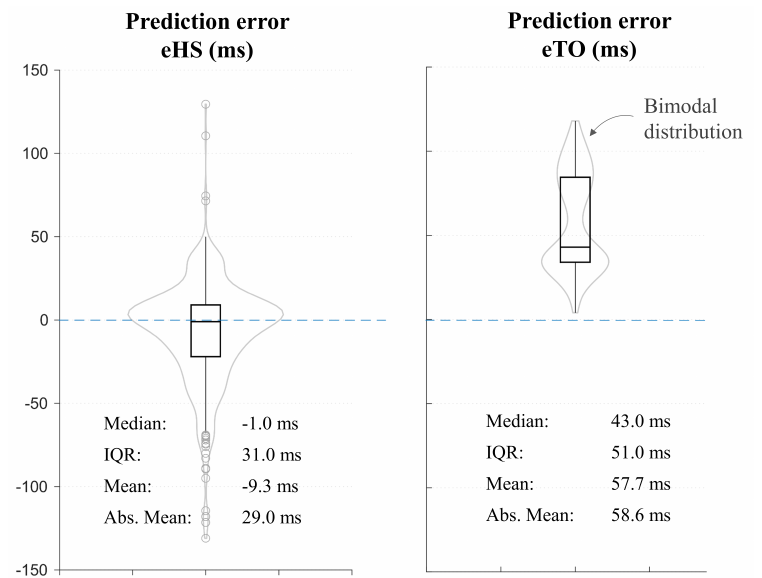
Figure 2. Heel strike ( left ) and Toe-off ( right ) error plots for all 2595 walking cycles. Boxplots (black) are superimposed with violin plots (in grey) indicating error distribution. Key statistics are also indicated below each plot. The box indicates the lower and upper quartiles with the central line showing the median. The top and bottom lines of the box represent, respectively, the medians for the upper and lower halves of the data and the whiskers represent the highest and lowest values of the distribution, excluding outliers. Outliers are also presented as circles.